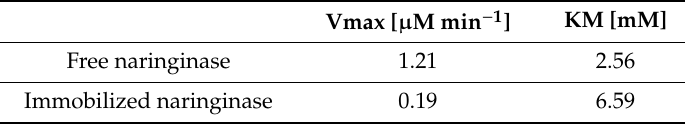
Table 3. Kinetic parameters of free and immobilized